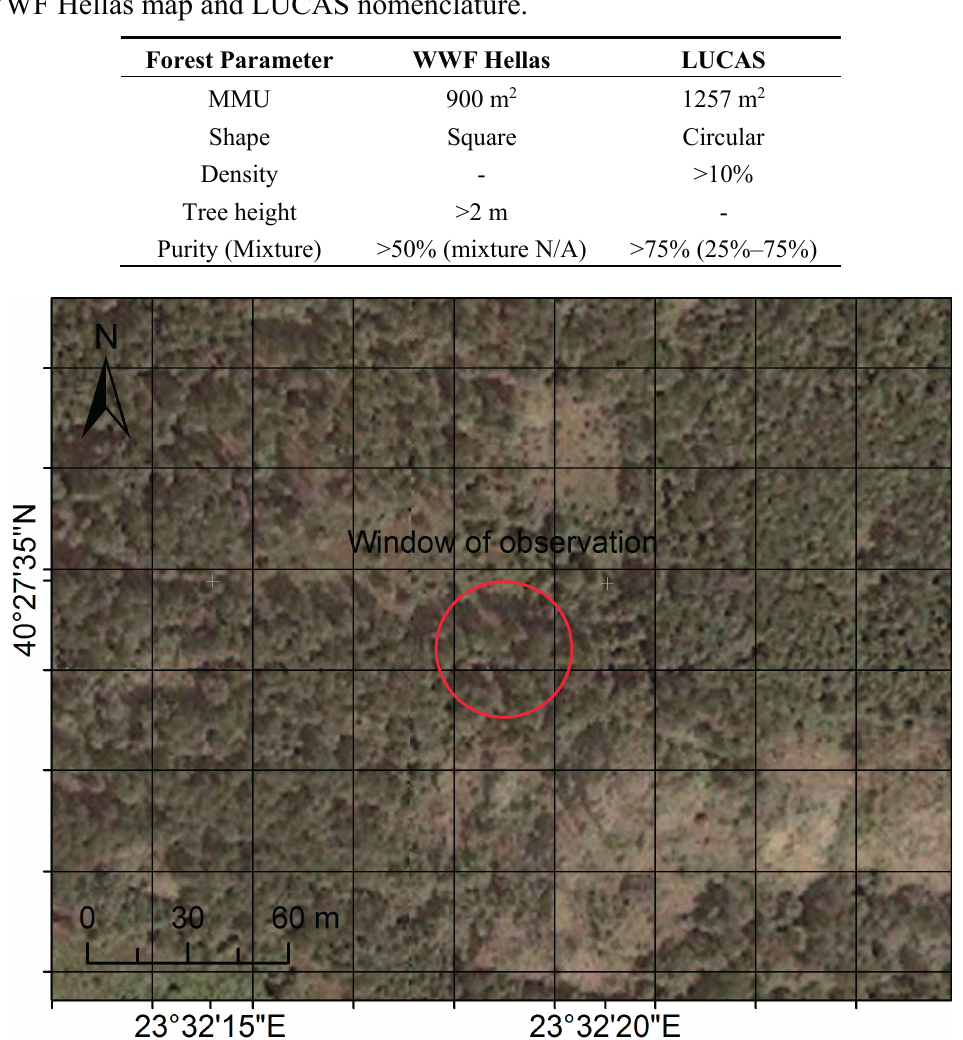
Figure 4. Comparison of the minimum mapping unit of the WWF Hellas map (identical to the Landsat pixel size, 30 m; here depicted as a 30 × 30 m grid) and the LUCAS extended window of observation (20-m radius; here depicted as a red circle) in a forestland in Greece (image background: ArcGIS©